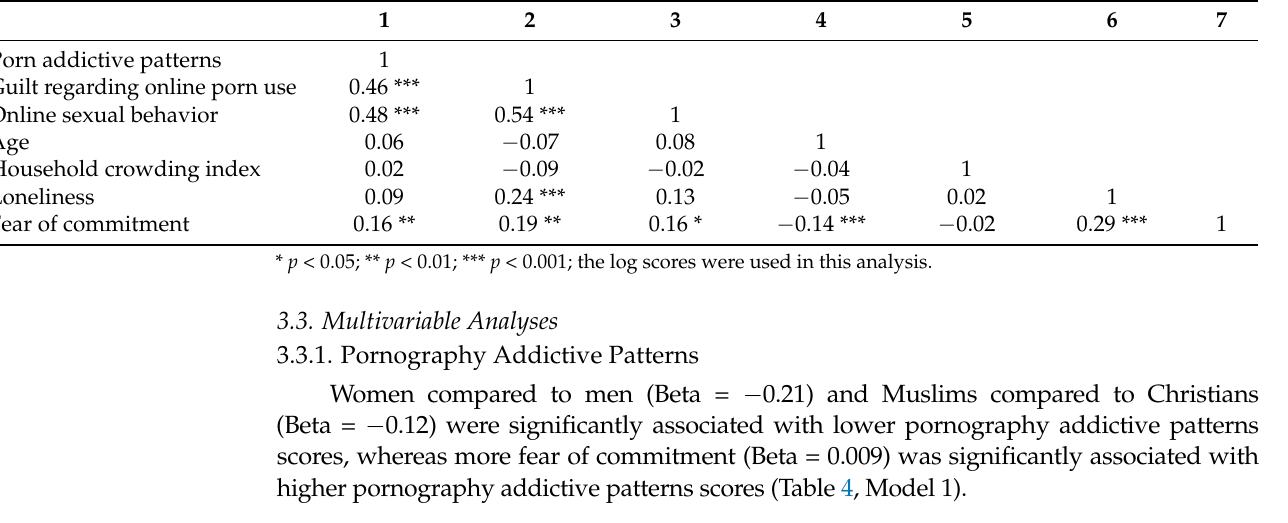
Table 3. Correlation matrix of the continuous